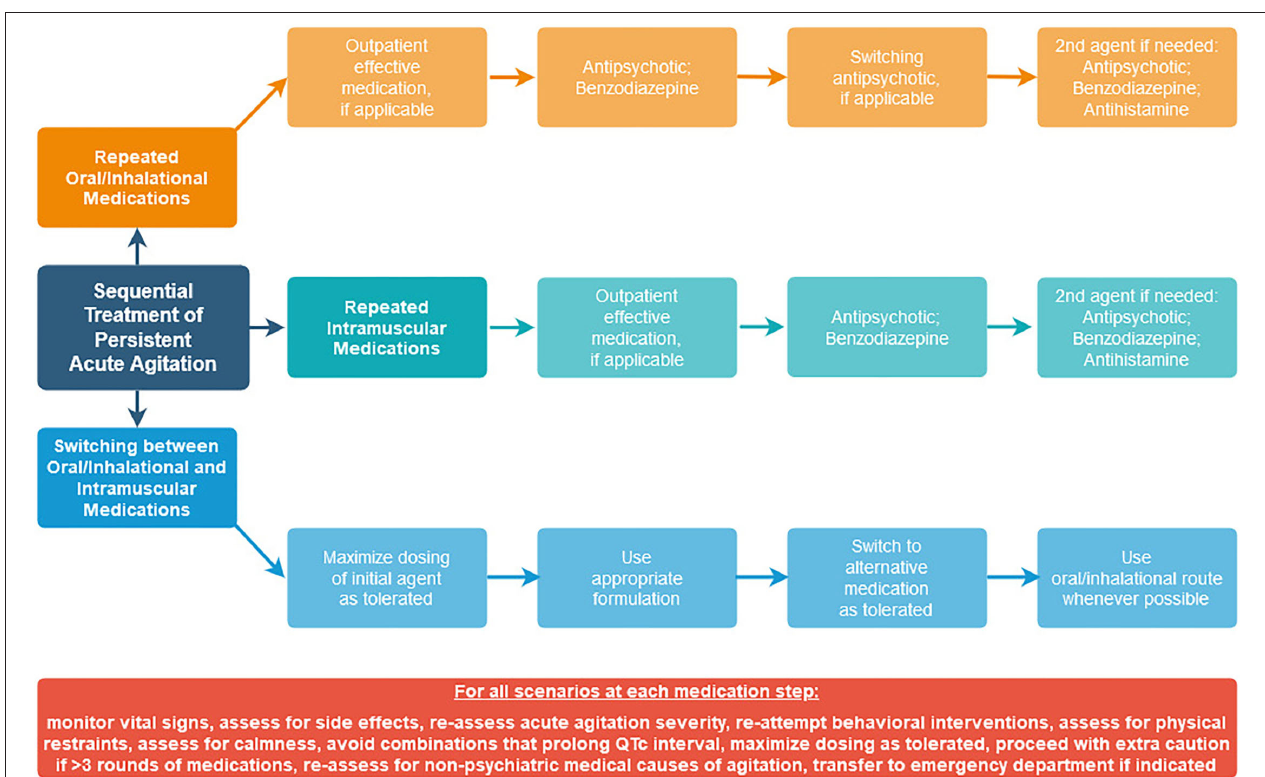
FIGURE 1 | Sequential treatment algorithms for persistent acute